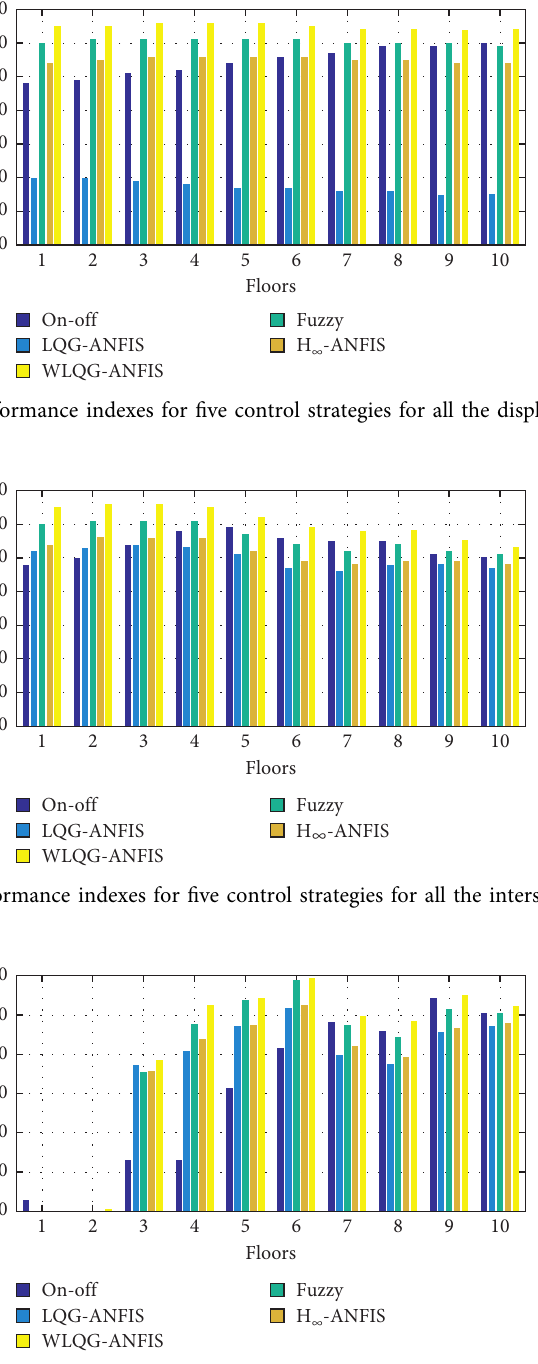
Figure 17: Performance indexes for five control strategies for all the